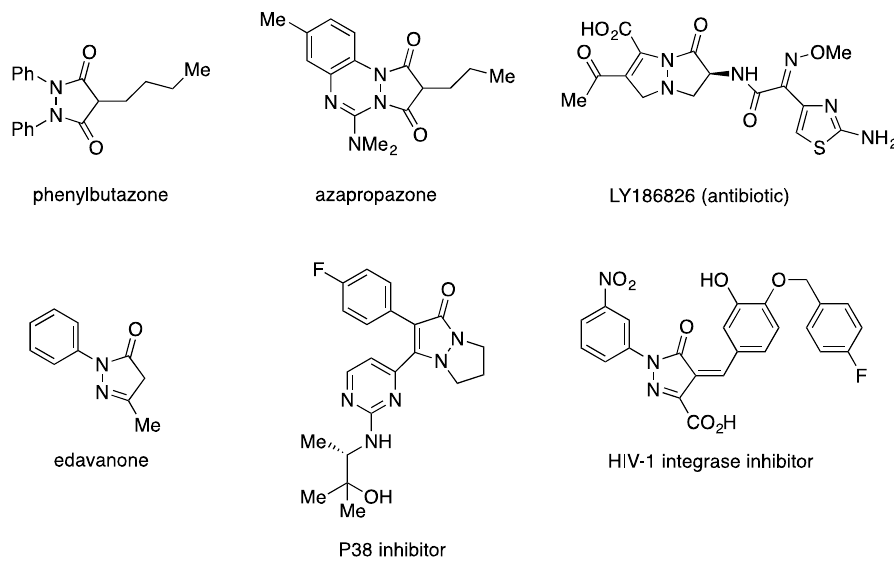
Figure 1. Selected biologically active pyrazolidinones and pyrazolones.